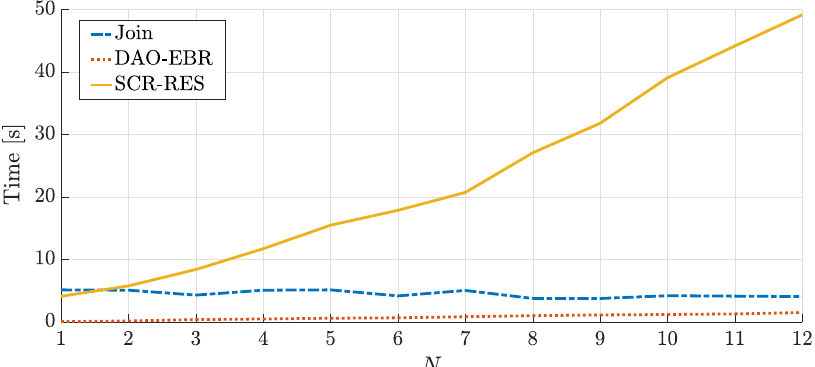
Figure 7. Comparison among times required by the different phases of the discovery procedure, with CCR set to 8 Hz.